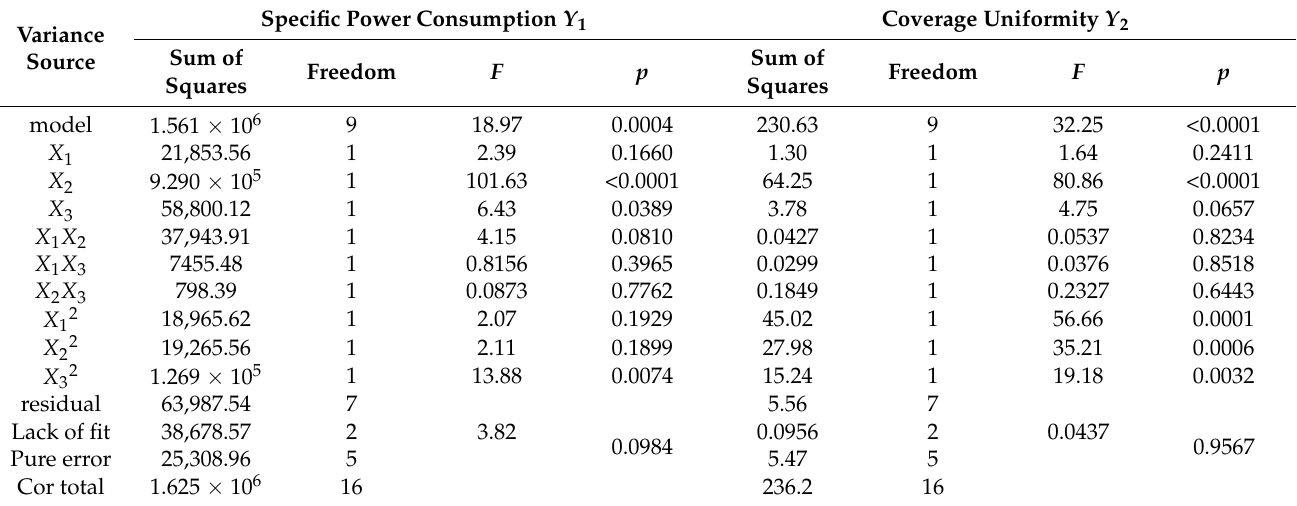
Table 4. Variance analysis of regression equation.